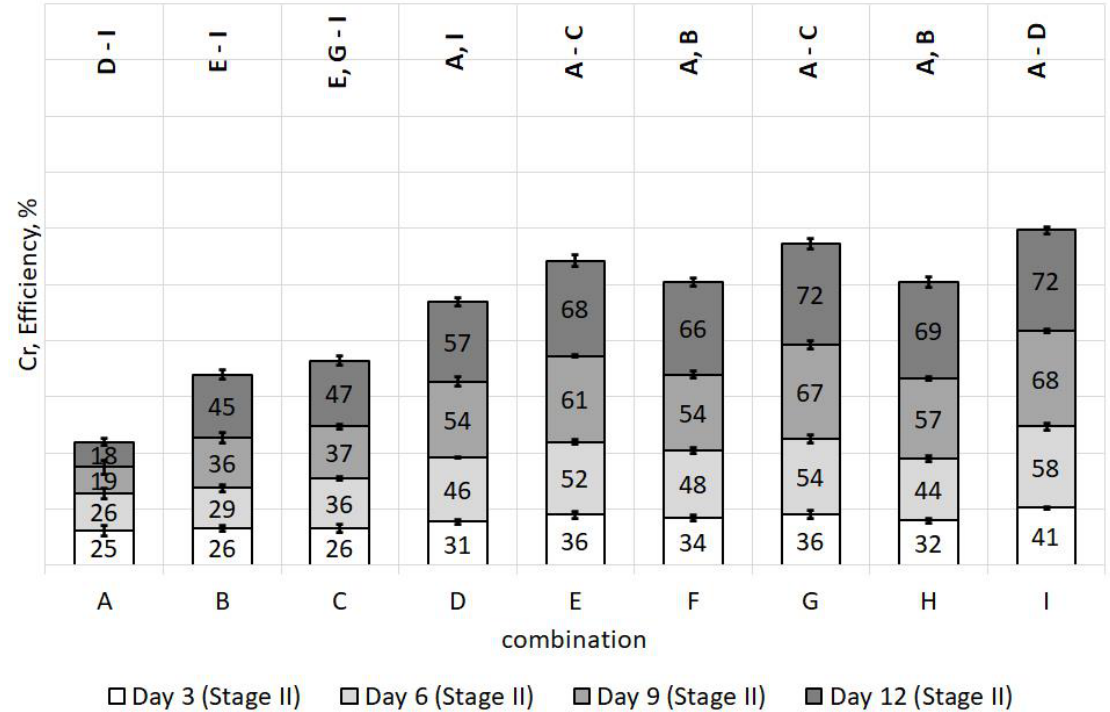
Figure 10. Effectiveness of Cr release to the dissolved fraction of leachate (Stage II). the process time (Figures 11 and 12). High efficiency was obtained in combinations E, G, I, in which sample pre-acidification was used. The maximum values of Cu bioleaching